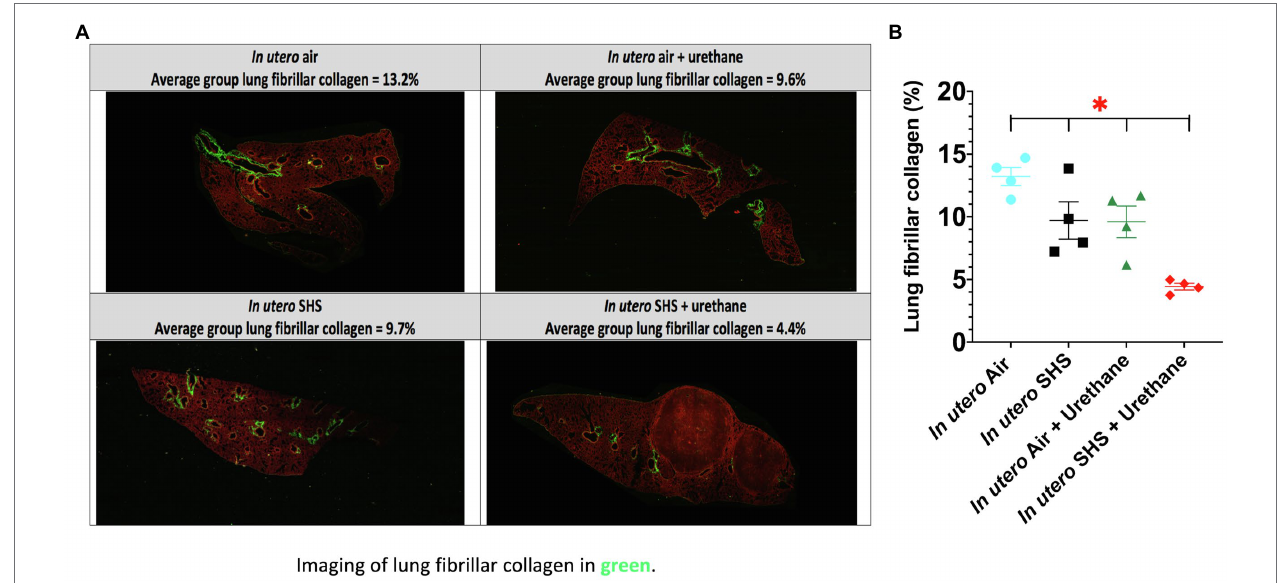
FIGURE 12 | In utero SHS plus adult urethane treatment significantly decreased the percentage of lung fibrillar collagen at 58 weeks. (A) Representative images obtained by second harmonic generation (SHG) microscopy of lungs slides from 58-week-old female mouse offspring. SHG (lung fibrillar collagen) and two-photon excited fluorescence are represented in pseudo color, green and red, respectively. (B) Quantification of lung fibrillar collagen content observed by SHG microscopy. For each mouse, three different lung sections were imaged by SHG microscopy. N = 4 mice per group, data are expressed as mean ± SEM. ANOVA, followed by the Tukey’s test for multiple comparisons, * p < 0.05: statistically different from all other